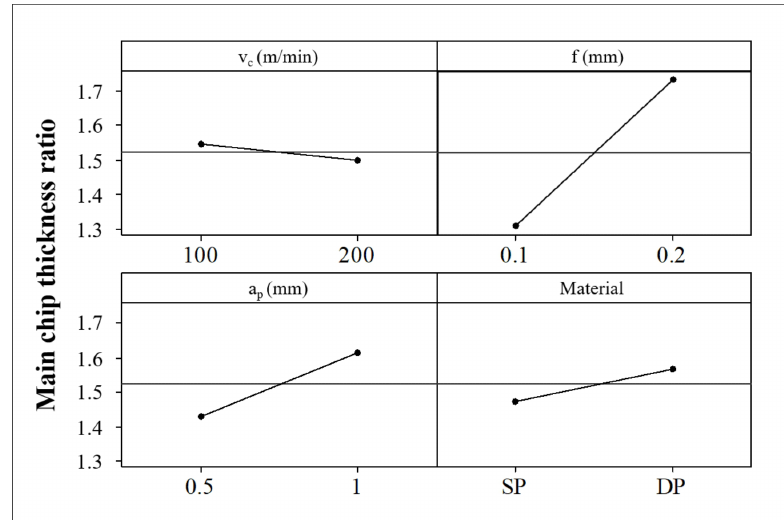
Figure 9. Main effects plot of cutting parameters and manufacturing route on the chip thickness